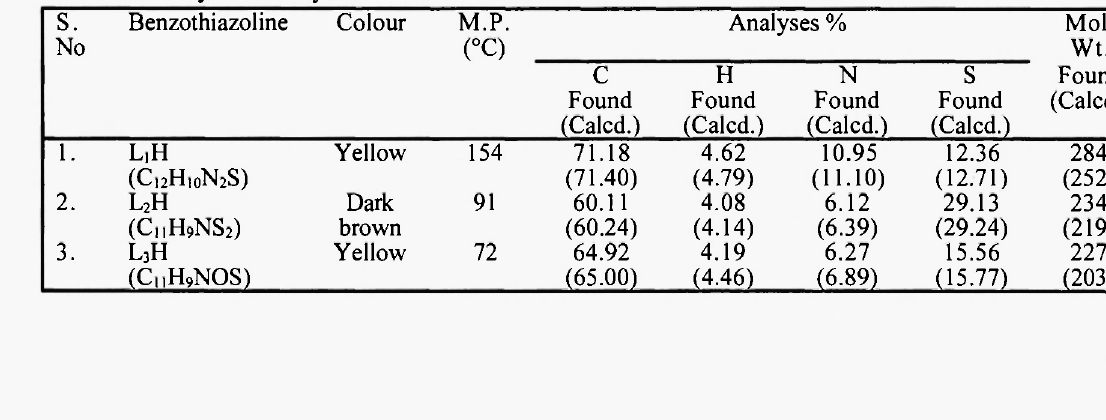
Table I: Physical Properties and Analytical Data of Monofunctional Bidentate Benzothiazolines Derived from Heteroyclic